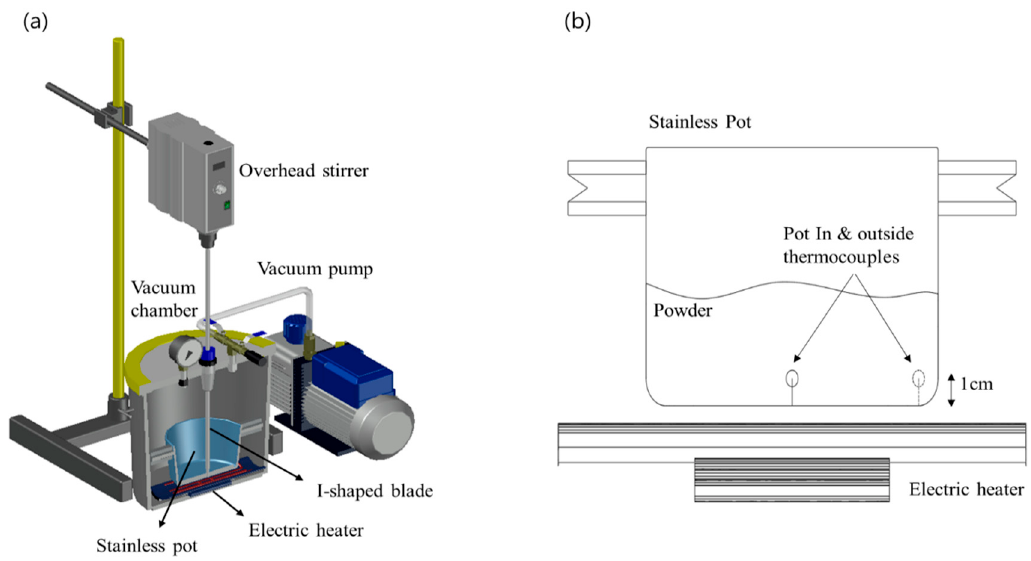
Figure 1. Configuration and appearance of the vacuum heating system ( a ): schematic diagram of the system and ( b ) the internal layout of the vacuum chamber.